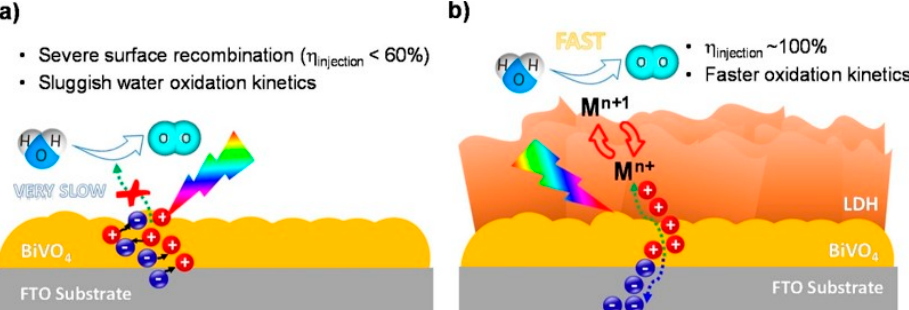
Figure 8. Schematic representation of charge carrier dynamics in water oxidation on BVO ( a ) and BVO/CMZ ‐ LDH ( b ) photoelectrodes. Adapted from Reference [141]. Copyright 2019 Elsevier.